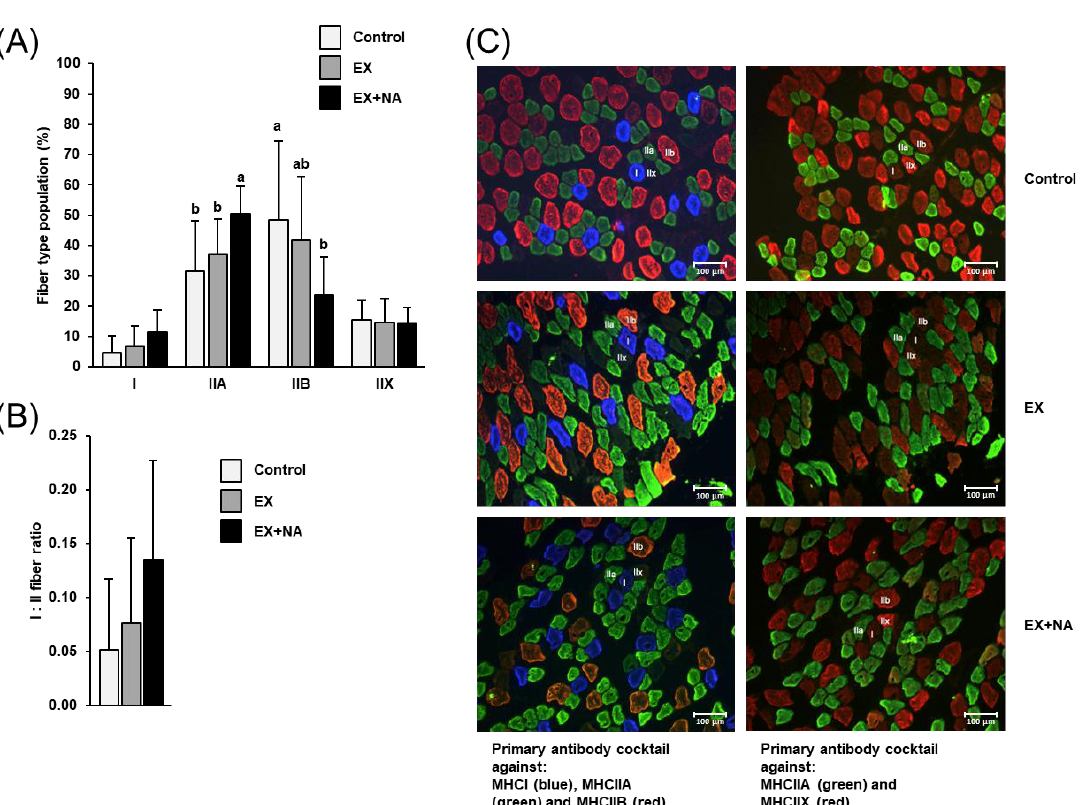
Figure 3. Fiber type composition ( A ) and fiber type I:type II ratio ( B ) of gastrocnemius muscle of sedentary mice fed an NA (nicotinic acid) adequate diet (Control) and mice subjected to regular endurance exercise fed either an NA adequate diet (EX) or a high NA diet (EX + NA) for 6 weeks. Bars represent means ± SD for n = 10 animals per group. Bars without a common lowercase letter (a, b) differ, P < 0.05. ( C ) Representative images were obtained from two sequential cross-sections of each muscle sample stained with two different primary antibody cocktails (left: 1, right: 2) in order to discriminate the four fiber types. In cross-section 1, blue fibers were classified as type I, green fibers as type IIA and red fibers as type IIB. In cross-section 2, green fibers were classified as type IIA and red fibers as type IIX. For fiber typing, per animal all fibers within two representative fields-of-view at a 100-fold magnification were counted and typed. Bar represents 100 µm.